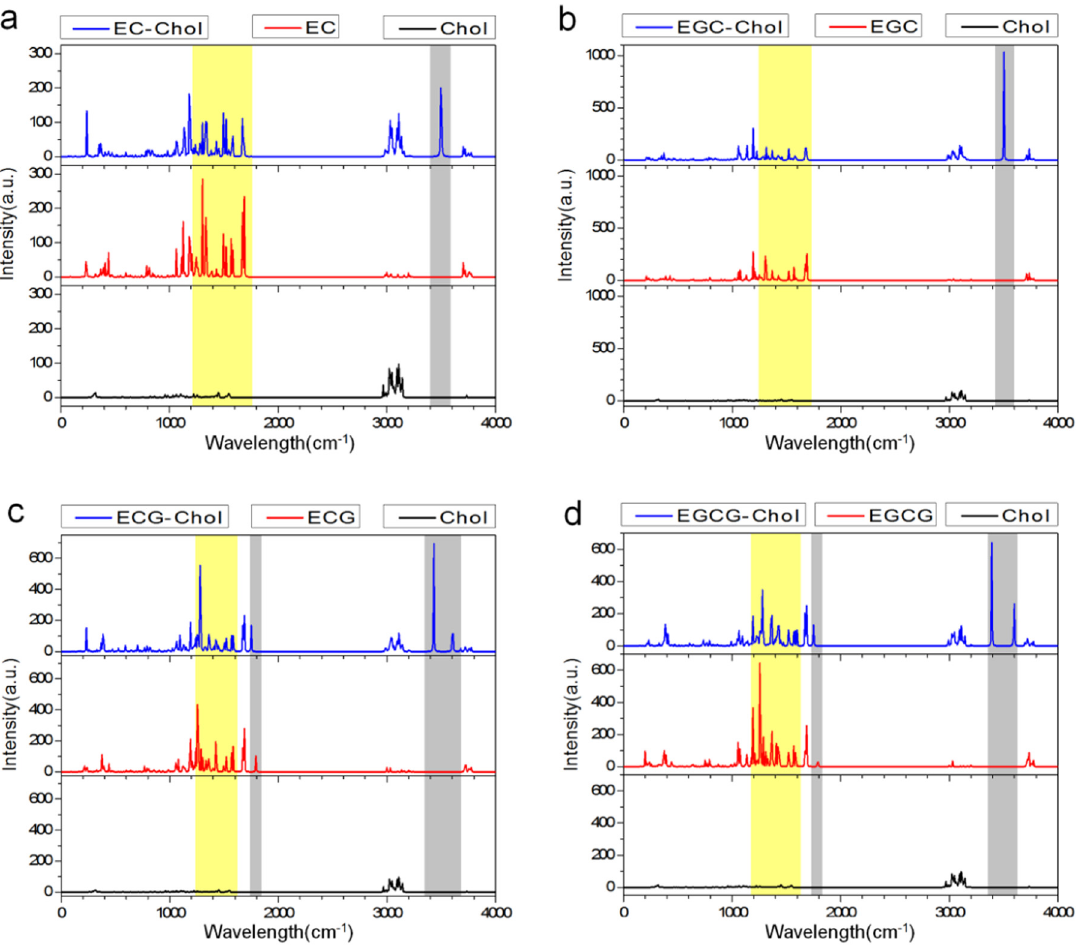
Figure 8: IR spectra of catechin, cholesterol and catechin – cholesterol